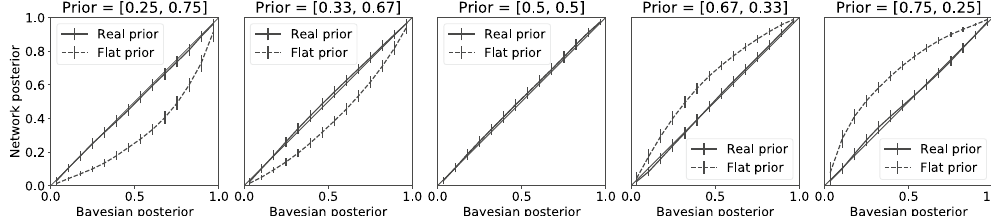
Figure 2. Network posterior matches optimal Bayesian estimates. The neural network learned to choose each class with a certain probability by getting feedback about correct or incorrect classification. Based on Bayesian statistics the optimal posterior estimate depends on the prior probability of a class occurring. This prior probability was influenced by the relative frequency that a stimulus from a class was shown during training. Five prior probability ratios were tested: [0.25, 0.75], [0.33, 0.67], [0.5, 0.5], [0.67, 0.33] and [0.75, 0.25] for class 1 and class 2 respectively. The posterior that the network learned is plotted against the optimal Bayesian estimates that accounts for the prior (solid line), or that ignores the prior probability, i.e. a uniform prior (dashed line). The network posterior matches the optimal Bayesian estimate that accounts for the prior and thus learns to correctly incorporate prior knowledge in its connections. Error bars represent standard deviation over the validation trials.